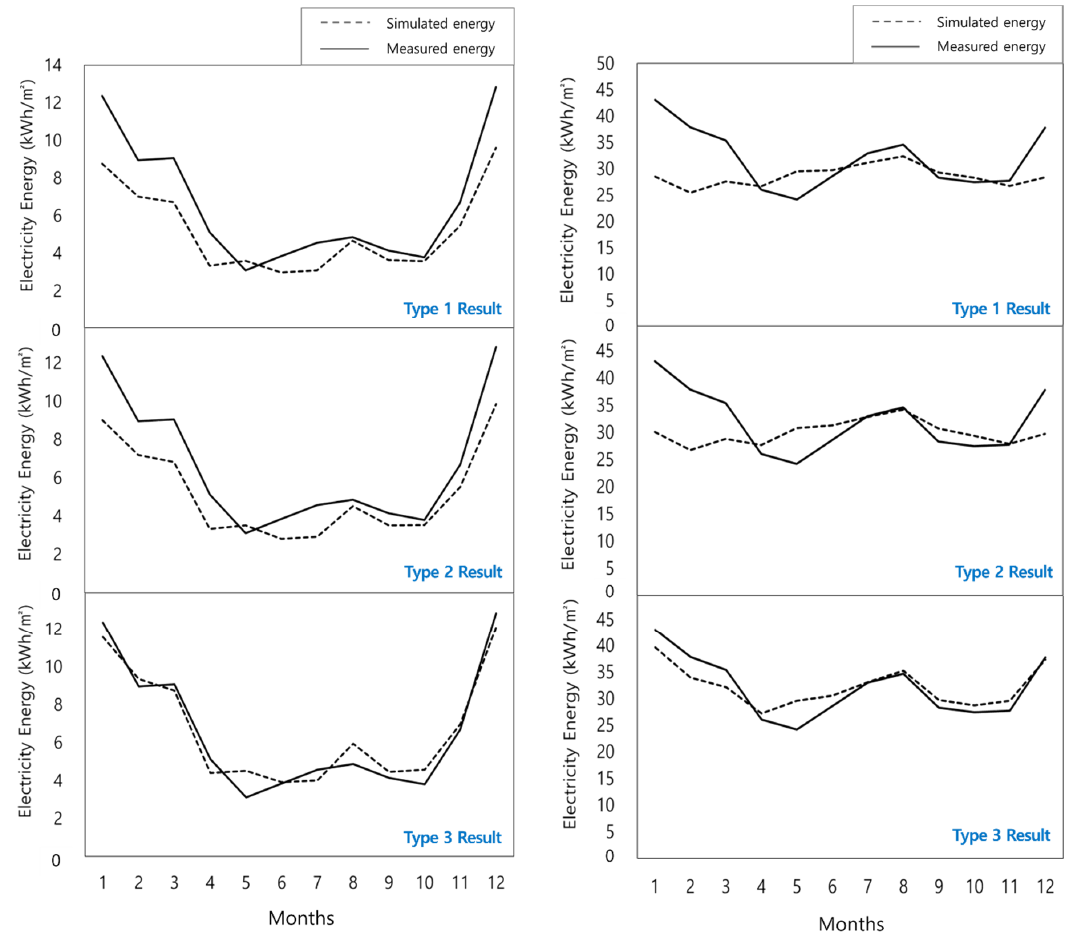
Figure 5. Simulated energy compared with measured energy. (left: UB1, right: UB2). Table 10. Results of model calibration.